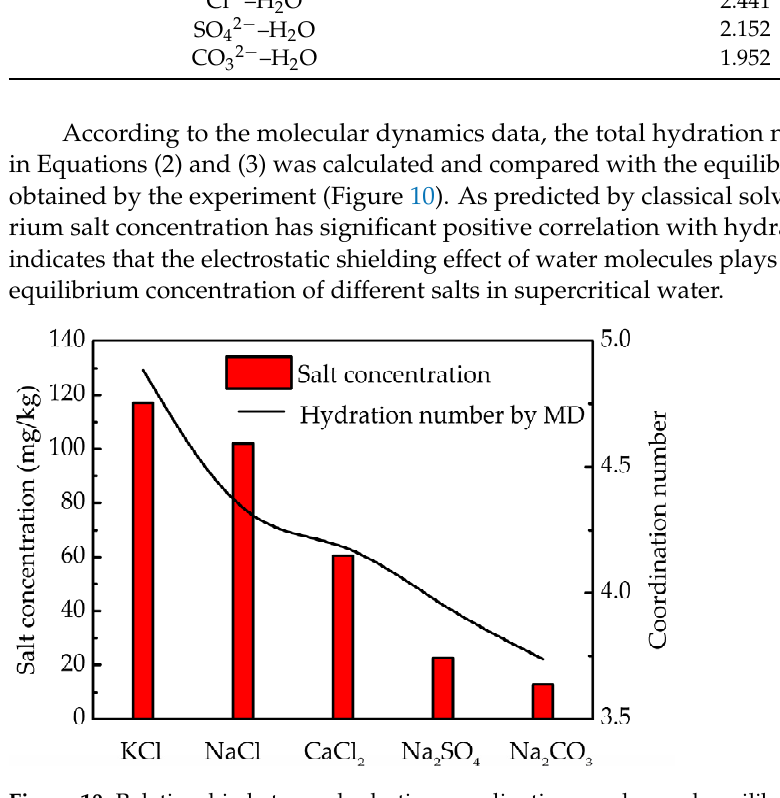
Figure 10. Relationship between hydration coordination number and equilibrium concentration in different inorganic salt systems.